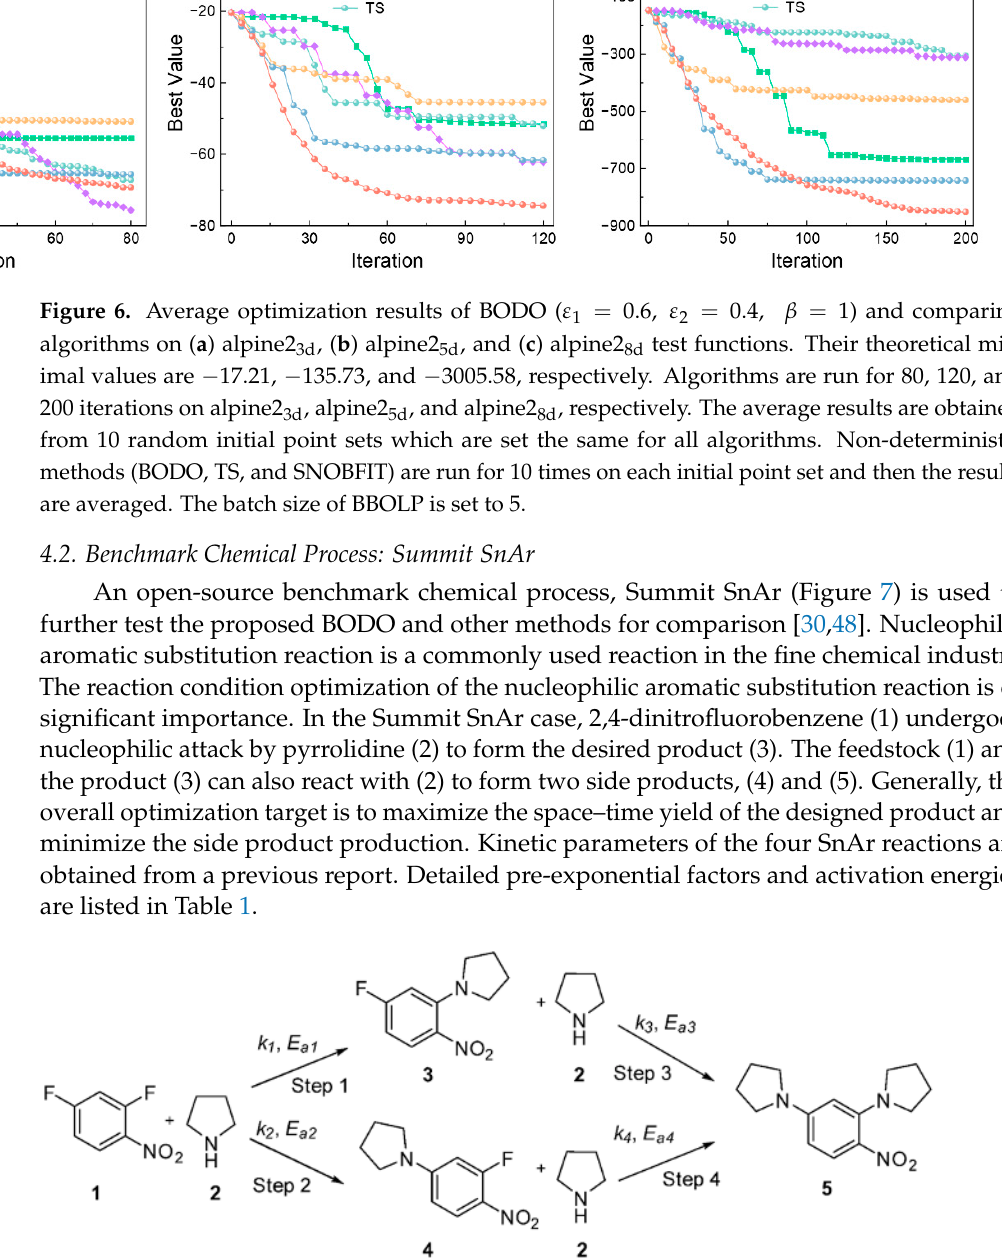
Figure 7. Chemical reactions of the Summit SnAr benchmark chemical process. Table 1. Pre-exponential factors and activation energies of Summit SnAr reactions.